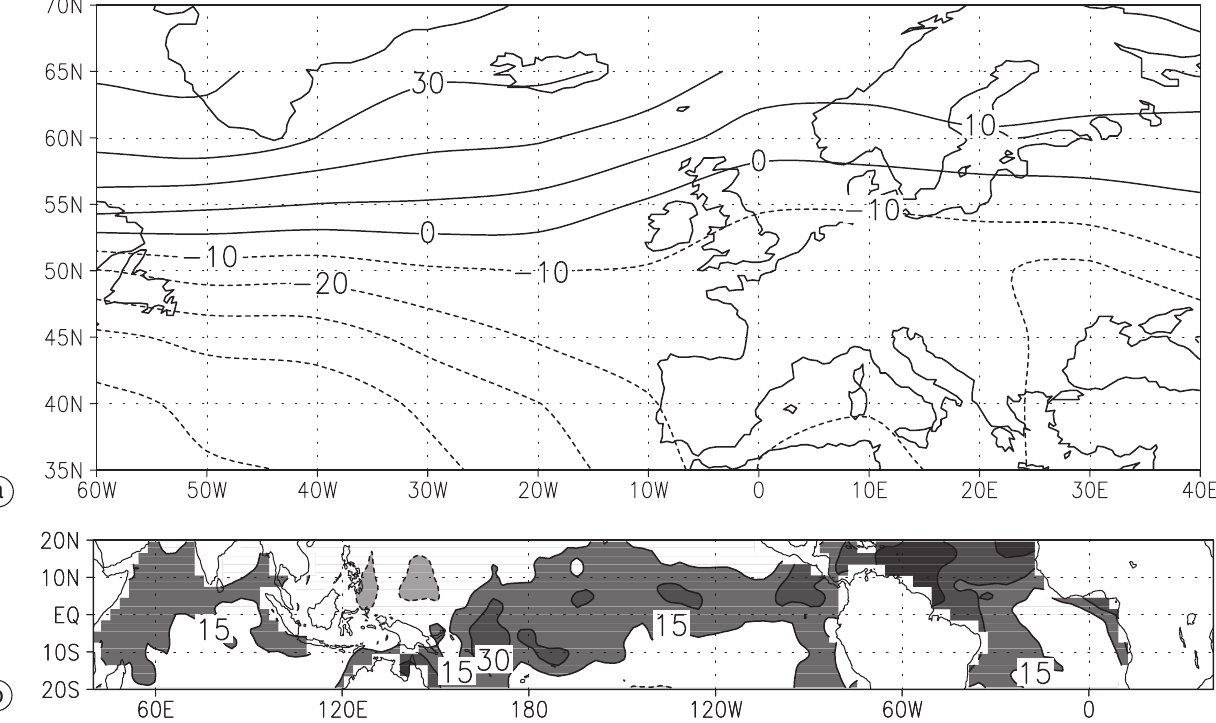
Fig. 1a,b. Leading pair of heterogeneous correlation patterns from an SVD analysis of 92 years (1903-1994) of gridded observations of JFM seasonal mean tropical SST and JFM seasonal mean Atlantic/European MSLP. a) MSLP correlations (in %); b) SST correlations (in %). Squared covariance fraction = 73%. Total explained MSLP variance fraction in Atlantic/European region = 7%. Statistical significance level = 3.5%.